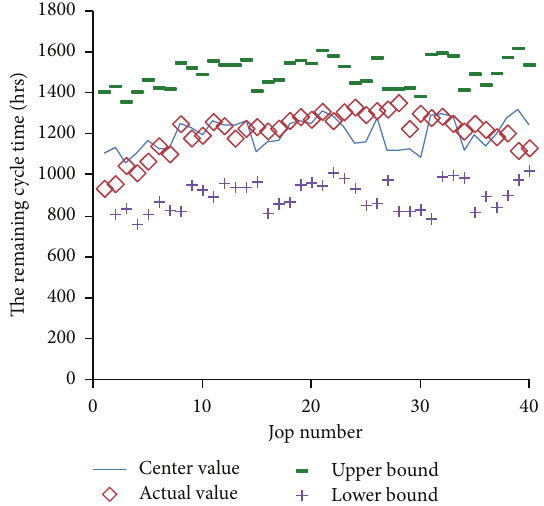
Figure 2: The estimation results by the effective FBPN approach. Figure 3: The estimation results by the statistical analysis